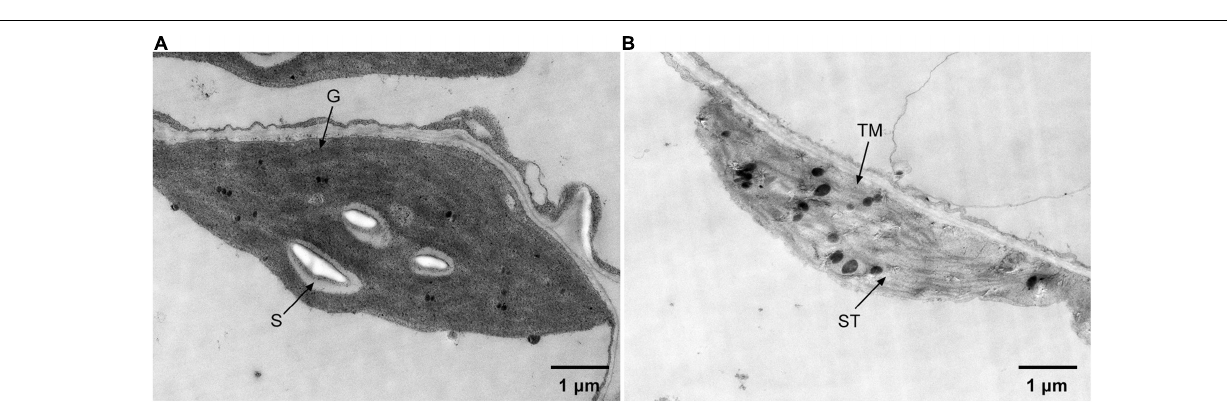
ultrastructure of chloroplasts. In detail, the chloroplasts in the control maintained a high stability status with normal grana stacks, starch particles, and thylakoid membrane ( Figure 7A ).